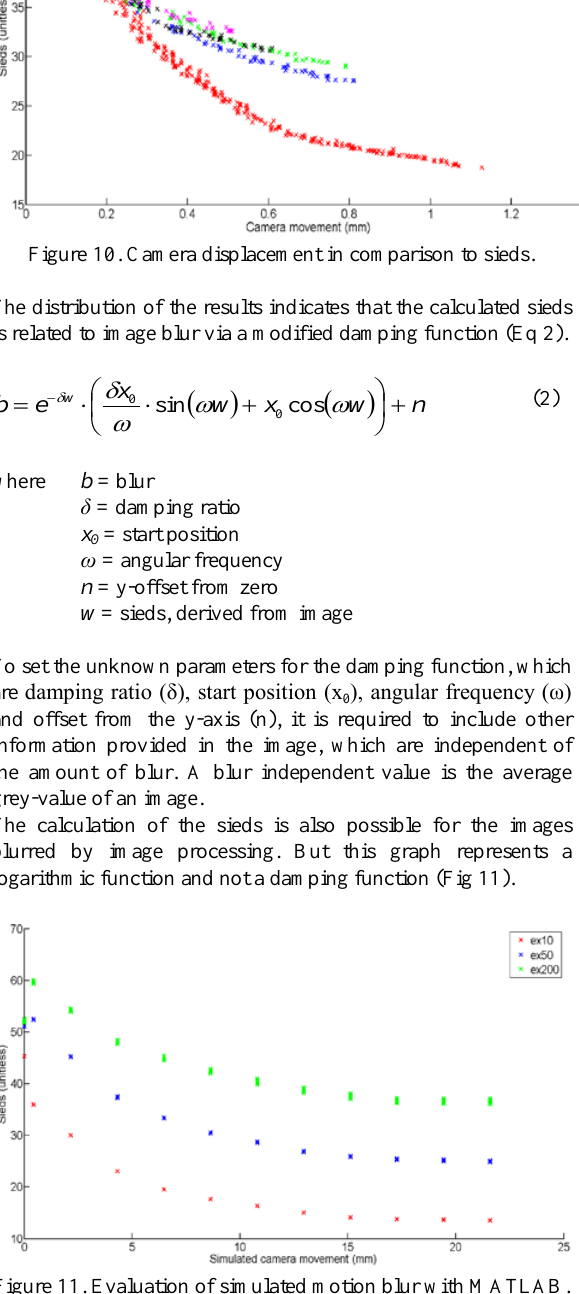
Figure 7. Comparison of produced blurred images with movement of camera and image exposure time. Pixel resolution 0.43mm.